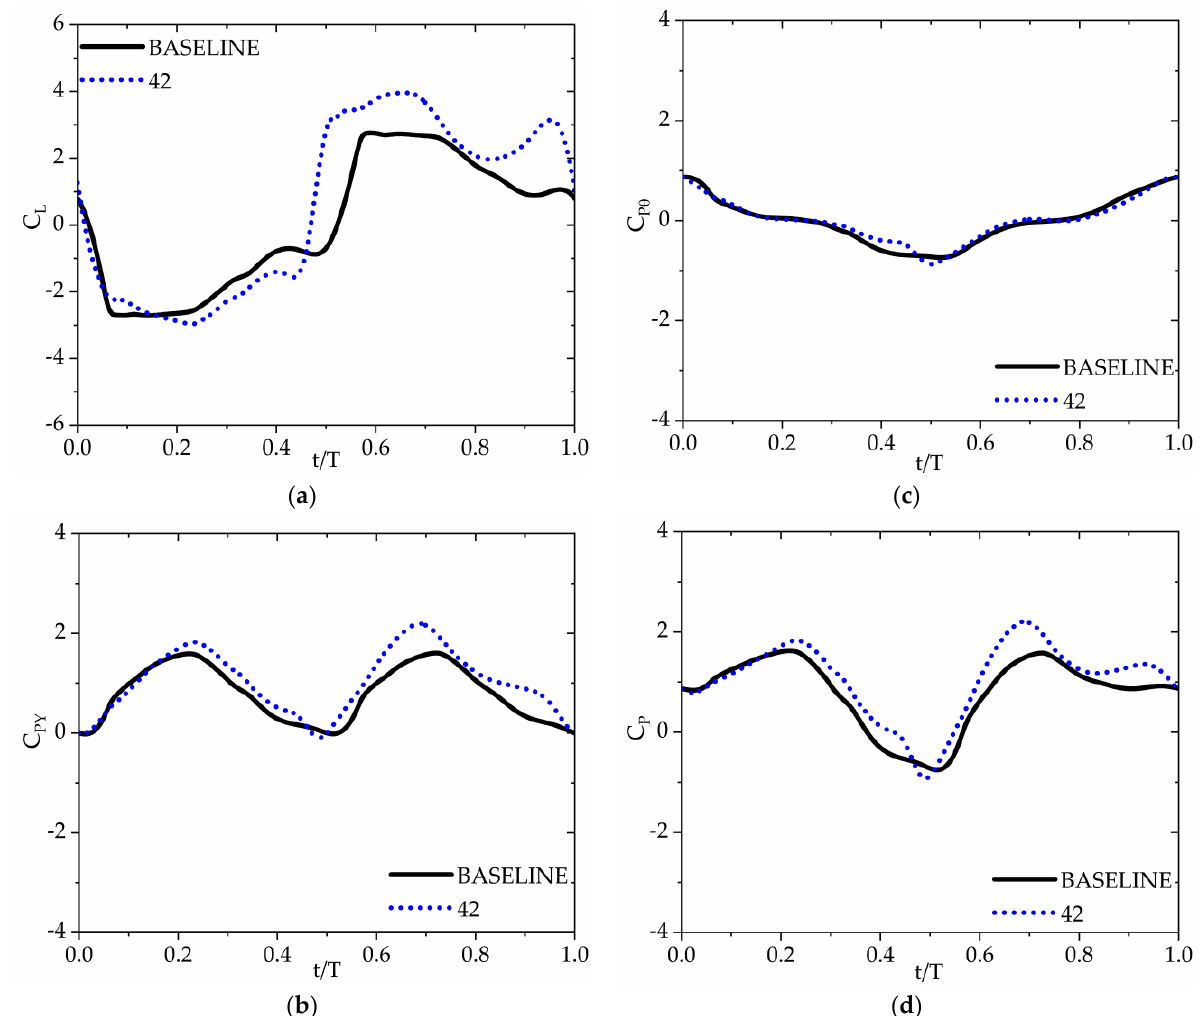
Figure 5. A comparison of the instantaneous lift and power coefficients between the upstream-deflector hydrofoil and the conventional hydrofoil (baseline). ( a ) Lift coefficient. ( b ) Heave power coefficient. ( c ) Pitch power coefficient. ( d ) Net power coefficient.